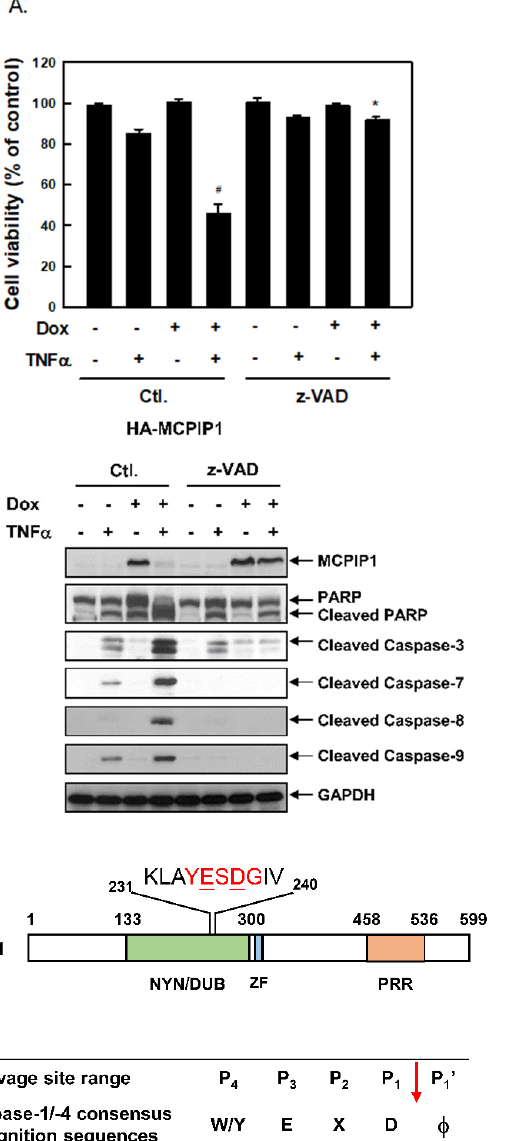
Figure 3. A pan-caspase inhibitor and caspase-1 inhibitor reversed apoptosis and caspase activation in TNF- α -treated cells. T-REx-293 cells with wild-type hemagglutinin (HA)-MCPIP1 were pretreated without or with 1 μ g/mL of doxycycline (Dox) for 16 h, and then treated with 10 ng/mL TNF- α for 2 h in the presence or absence of ( A ) 1 μ M of the pan-caspase inhibitor, z-VAD-fmk, ( B ) 1 μ M of the caspase-1 inhibitor, z-YVAD-fmk, or ( C ) 1 μ M of the JNK inhibitor, SP600125. Viable cells were determined by an MTT method. Each value is presented as the mean ± standard error of three independent experiments. # p < 0.05 vs. column 2 or column 3. * p < 0.05 vs. column 4 and column 7; & p < 0.05 vs. column 4. Total cellular lysates were collected, and protein expressions were determined by Western blotting. ( D ) Schematic representation of the monocyte chemoattractant protein-1-induced protein 1 (MCPIP1) protein containing Nedd4-BP1, YacP nuclease/deubiquitinase (NYN/DUB), CCCH-type zinc finger (ZF), and proline-rich (PRR) domains as well as putative caspase-1/-4-recognition sequences. The inherent capsase-1/-4 substrate specificity is shown. X is any amino acid, ↓ denotes the site of cleavage, and φ refers to G, A, T, S, and